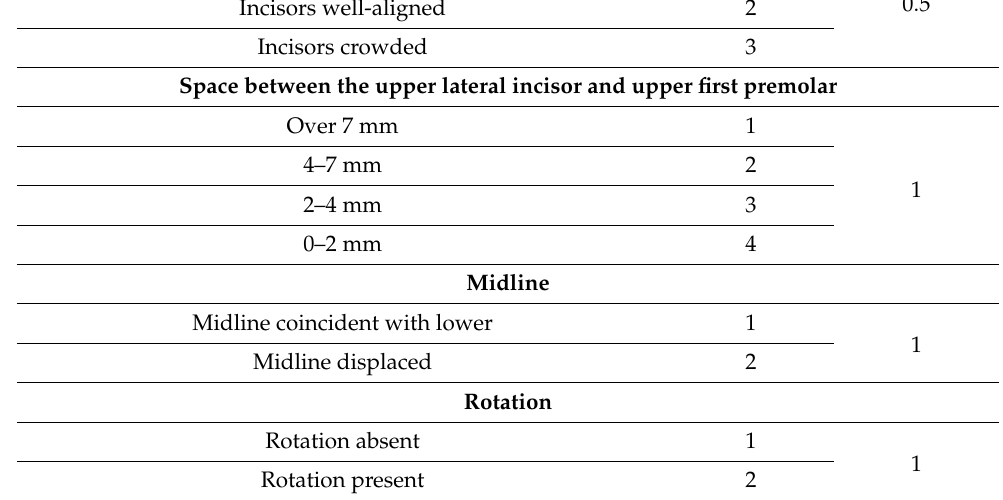
Table 1. Cont. Factors Score Weight Vertical position Canine cusp tip at the level of the amelocemental junction of the 1 adjacent incisor 1.5Canine cusp tip at the middle of the root of the adjacent incisor 2 Canine cusp tip within the apical third of the adjacent incisor 3 Canine cusp tip above the apical third of the adjacent incisor 4 Bucco-palatal position Buccal 1 1 Palatal 1 Horizontal position Canine overlapping less than half the width of the lateral incisor 1 2Canine overlapping over half the width of the lateral incisor 2 Canine completely overlapping the lateral incisor 3 Canine overlapping up to half the width of the central incisor 4 Alignment of upper incisors Incisors spaced 1 0.5Incisors well-aligned 2 Incisors crowded 3 Space between the upper lateral incisor and upper first premolar Over 7 mm 1 14–7 mm 2 2–4 mm 3 0–2 mm 4 Midline Midline coincident with lower 1 1 Midline displaced 2 Rotation Rotation absent 1 1 Rotation present